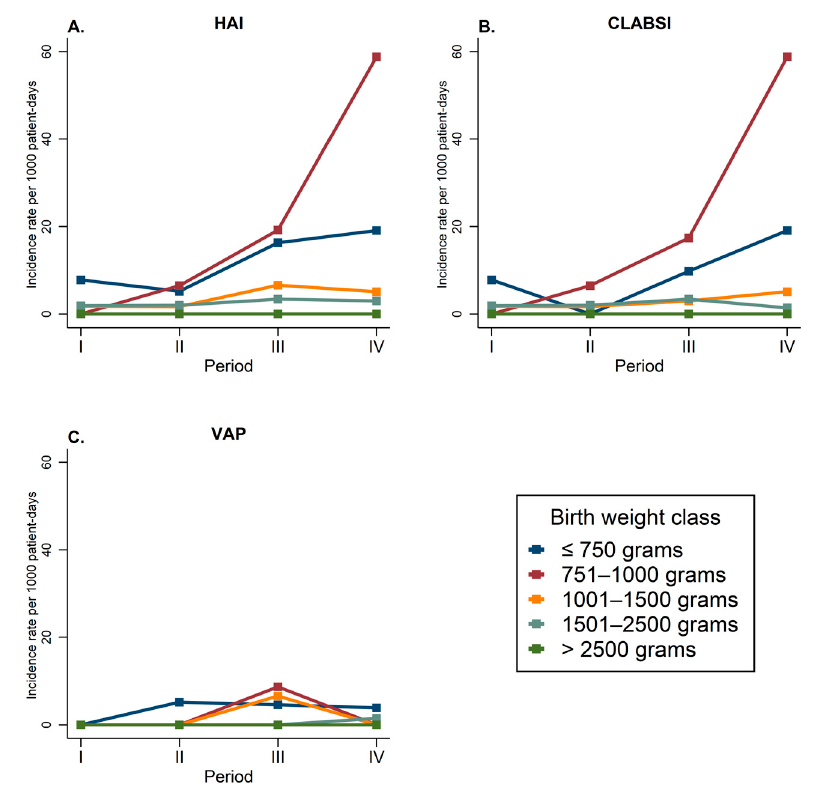
Figure 2. ( A – C ) Incidence rate of first healthcare-associated infection (HAI) occurring in patients admitted to the neonatal intensive care unit of Umberto I teaching hospital of Rome between March 2018 and February 2022 by study period.